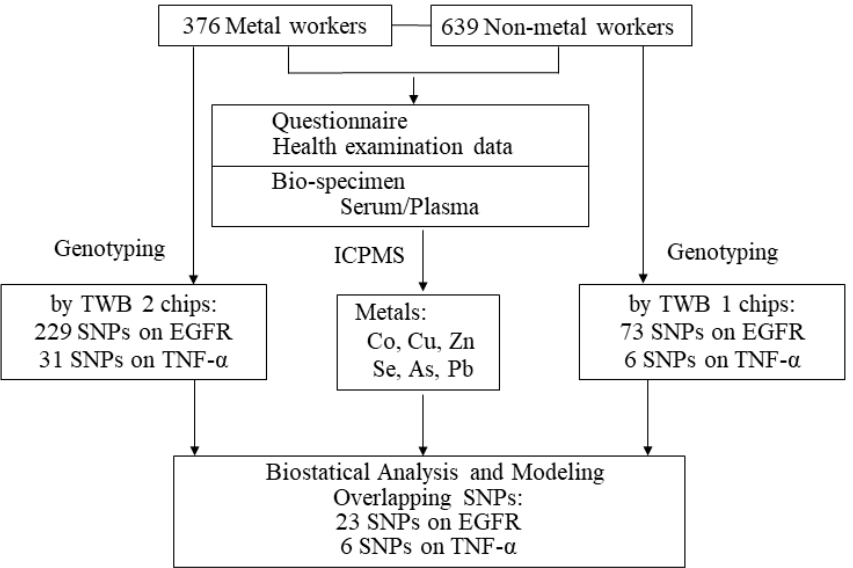
Figure 1. The study protocol.